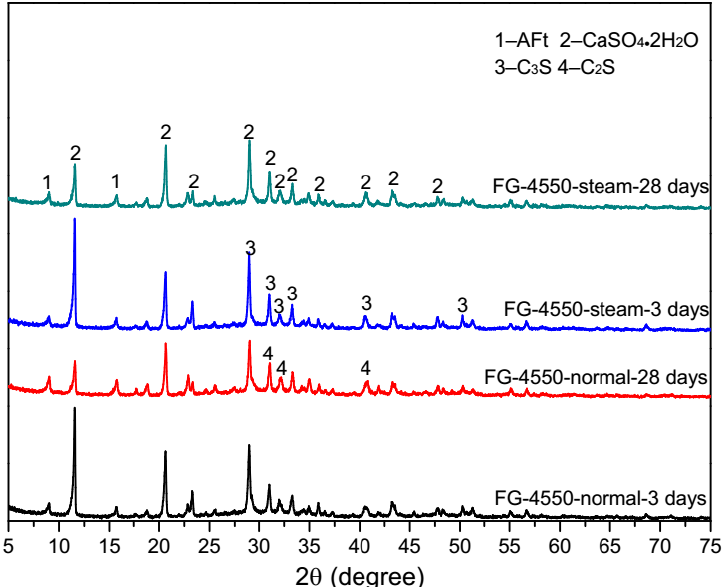
Figure 6. XRD patterns of FG‐4550 pastes under steam curing conditions and normal curing conditions.